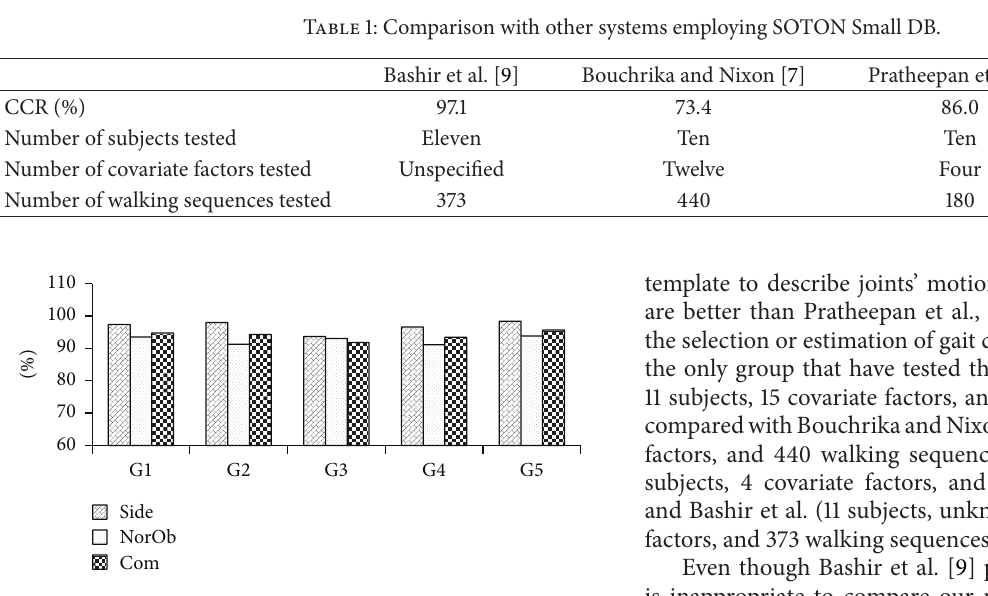
Figure 15: CCRs of group covariate factors for SOTON Small DB.